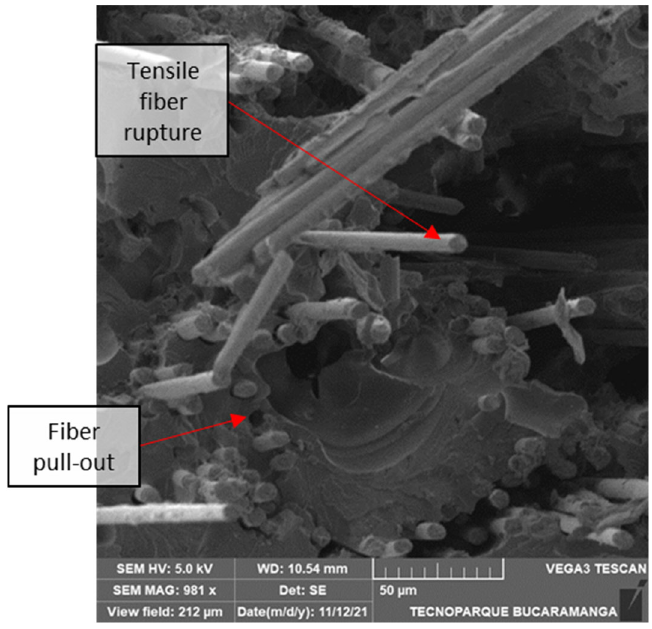
Figure 19. Flat 0° 2/16 ‐